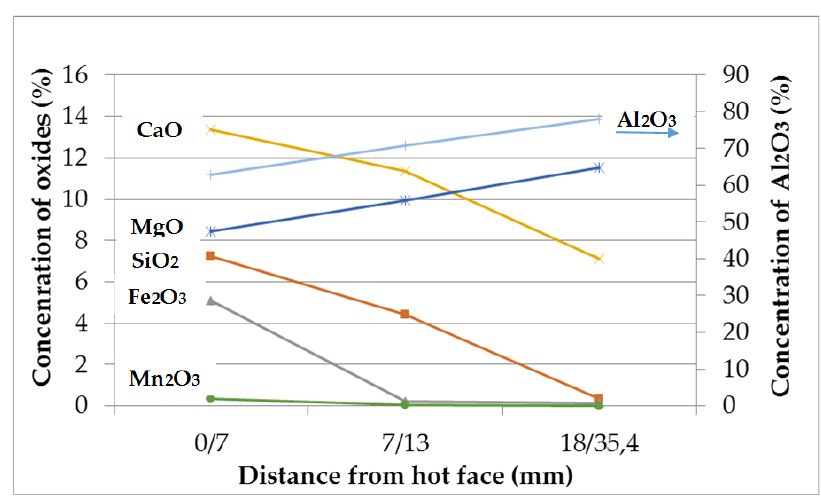
Figure 10. XRF analyses of samples taken at the different distances from the hot side.